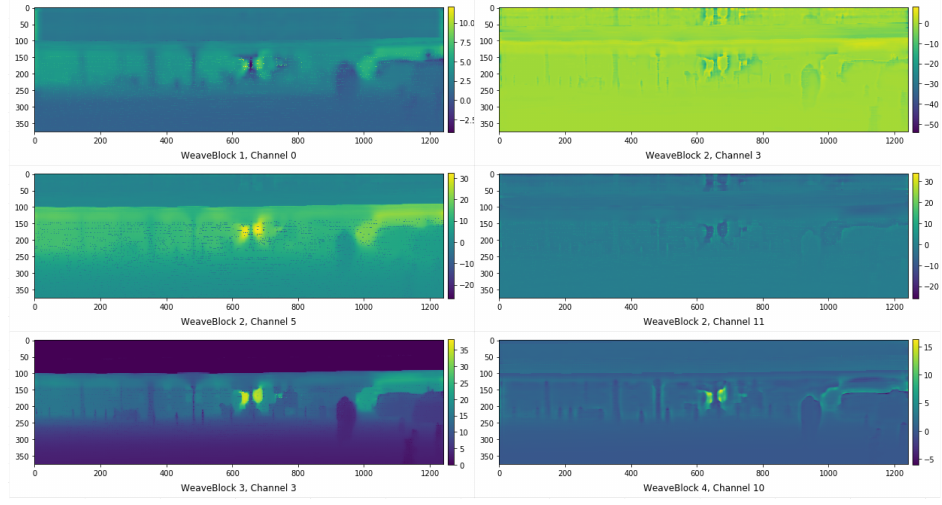
Figure 3. Example channels at the intermediate layers of WeaveNet; channels storing depth are on the left and channels storing edges are on the